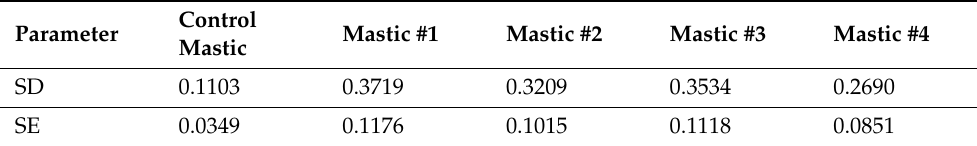
Table 7. ANOVA results of thermal conductivity.